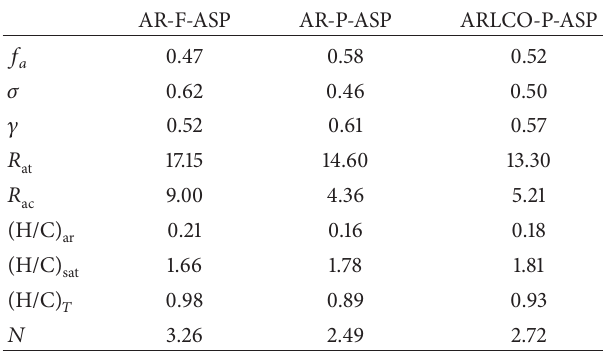
Table 5: Average structural parameters of asphaltenes obtained by 13 C-NMR and 1